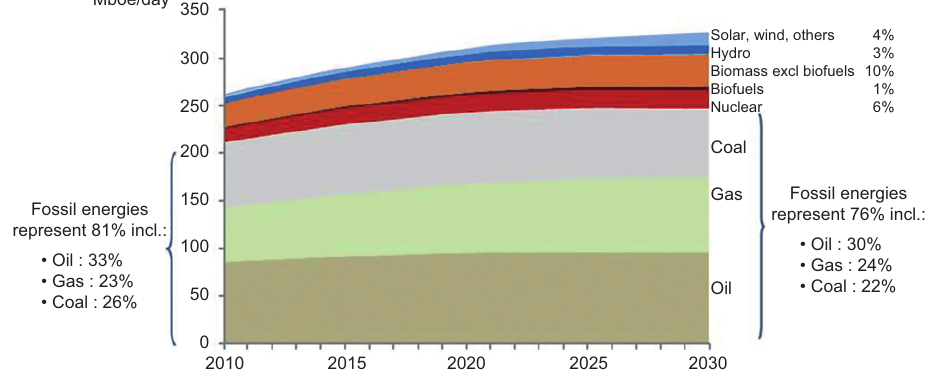
Figure 1 Evolution of world energy supply 2010 – 2030. Source: Total estimates after the Fukushima